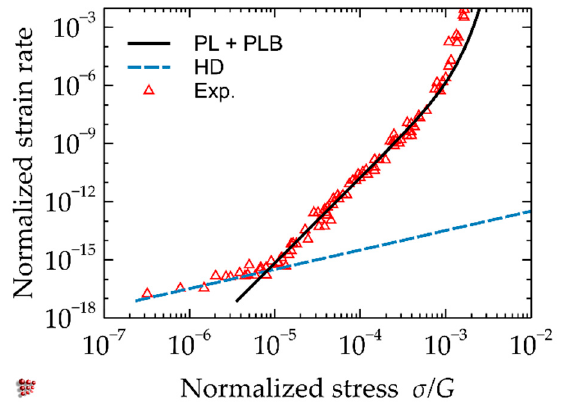
Figure 1. Harper–Dorn creep (HD), power law creep (PL), including power law breakdown (PLB). Symbols indicate experimental results for pure 99.999 Al from [48]. The normalized strain rate is defined by 𝜀(cid:4662) · 𝑘 (cid:2886) · 𝑇/𝐷 (cid:2915)(cid:2916)(cid:2916) · 𝐺 · 𝑏 .